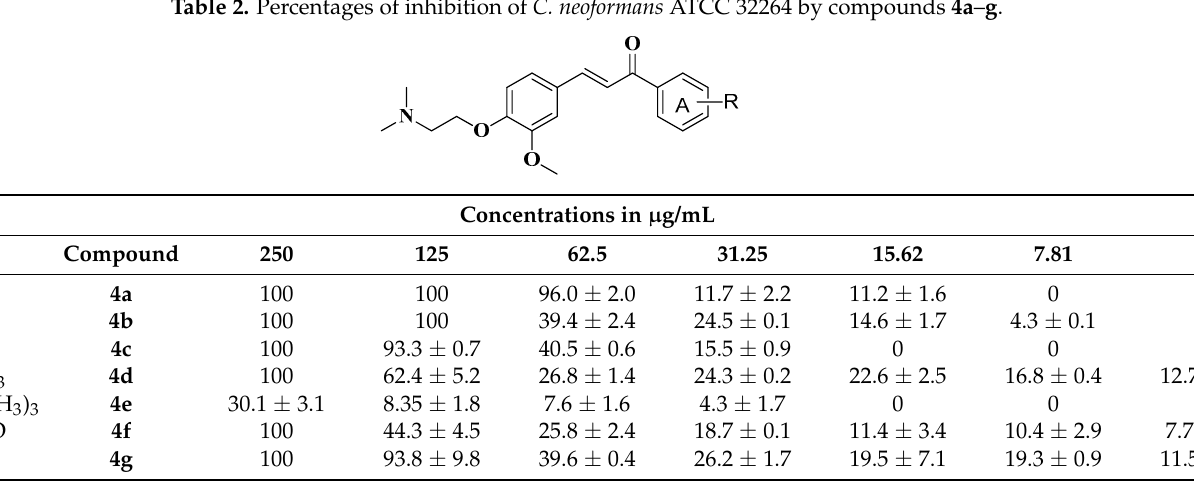
Table 2. Percentages of inhibition of C. neoformans ATCC 32264 by compounds 4a – g .